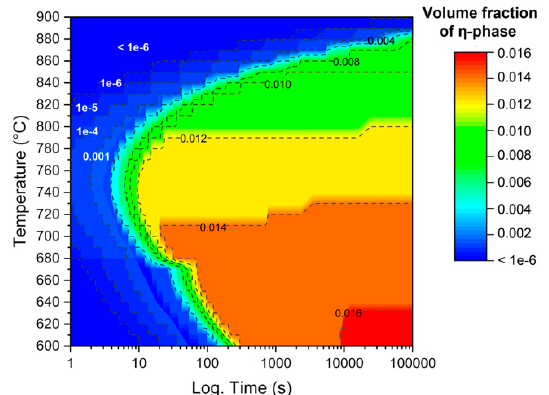
Figure 5. Isothermal precipitation diagram of η -phase in the trial High-Nb-SS steel.